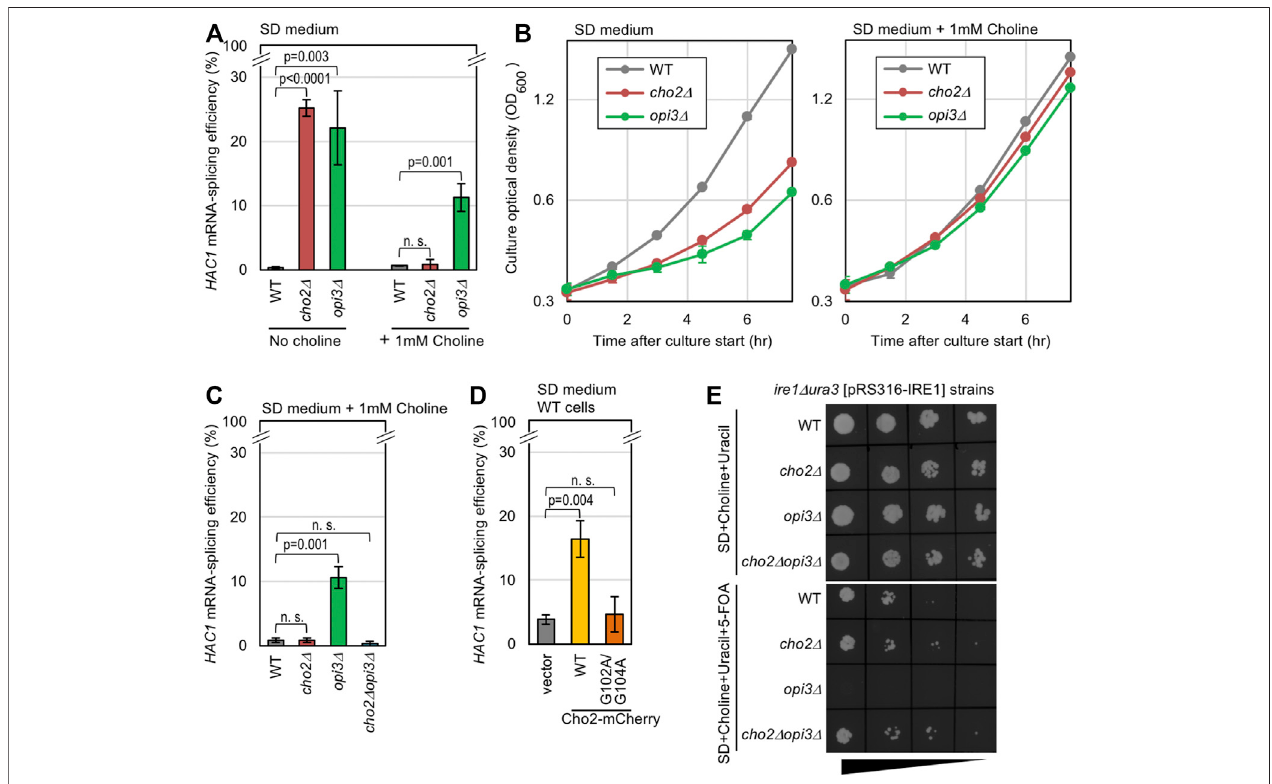
FIGURE 1 | Induction of UPR by genetic manipulations that causes PMME accumulation in yeast cells. (A – C) Wild-type (WT) yeast strain BY4741 and its gene- deletion mutants were grown in SD medium (with or without 1 mM choline) and were checked for HAC1 -mRNA splicing and culture density. (D) BY4741 cells (WTcells) transformed with the Cho2-mCherry expression plasmid pYT-TDH3p-CHO2-mCherry (WT), its G102A/G104A Cho2-mCherry variant, or the empty vector pRS316 were grown in SD medium and were checked for HAC1 -mRNA splicing. (E) ire1 Δ ura3 yeast cells (KMY1516) carrying the URA3 / IRE1 plasmid pRS316-IRE1 and the indicatedgene-deletion mutations weregrown inSD medium containing1 mM cholineand 50 µg/ml uracilfor approximatelysevengenerations. Afteradjustmentto OD 600 0.1, the resulting cultures were 5-fold serially diluted, and 5-µl aliquots were spotted onto the indicated agar plates, which were then incubated for 3 days before picturing. ns, not signi fi cant ( p >